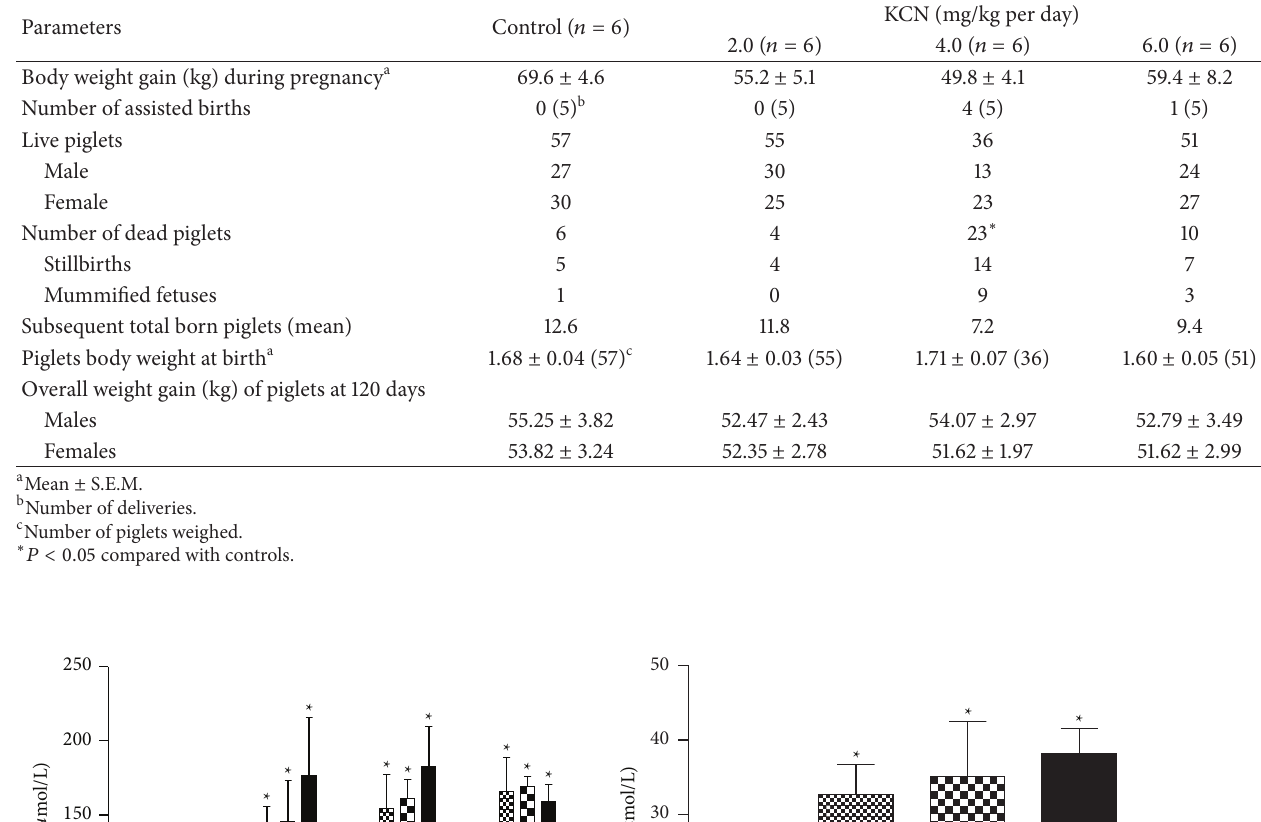
Table 1: Reproductive parameters from sows treated with KCN from day 21 of pregnancy to term and the body weight of their piglets at birth until 120 days old.